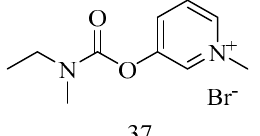
Figure 10. Currently approved drugs for treatment of Alzheimer’s disease (AD).